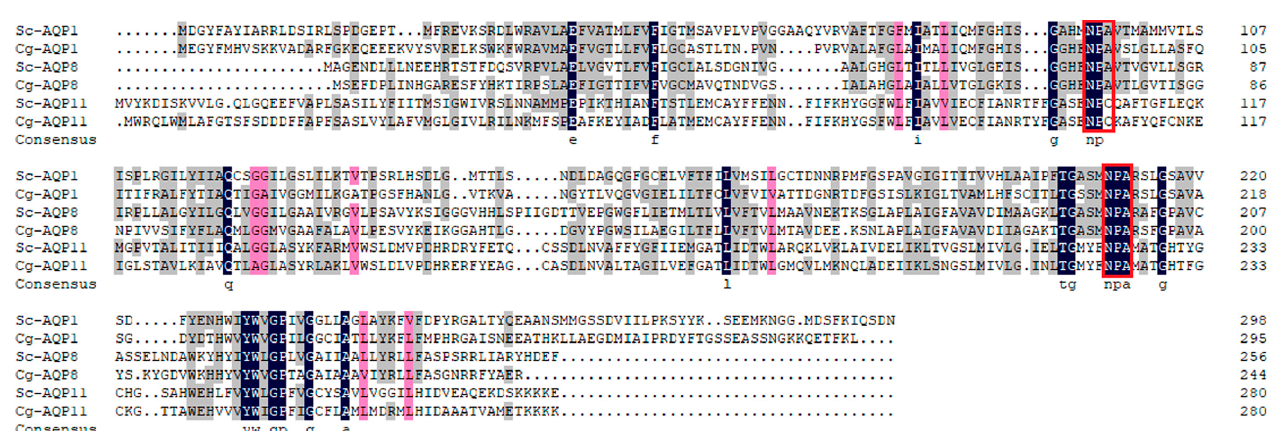
Figure 2. Three-dimensional structure of a functional unit of AQP protein predicted by SWISS-MODEL. The functional unit of AQP is a tetramer with each monomer providing an independent channel pore that transports water across the cell membrane ( ∗ ).